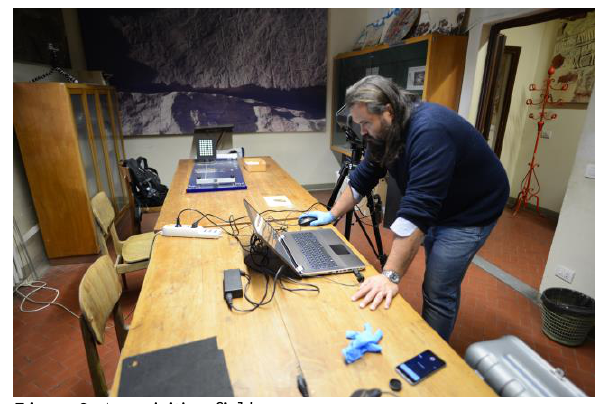
Figure 3: Acquisition